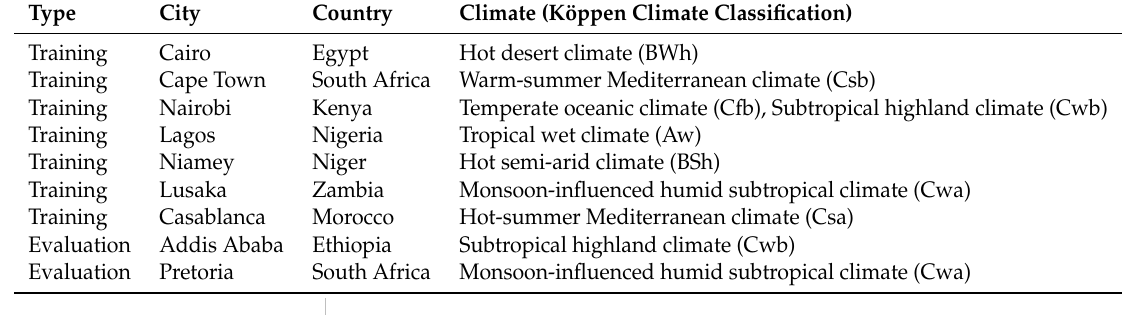
Table 3. African cities selected for this research.